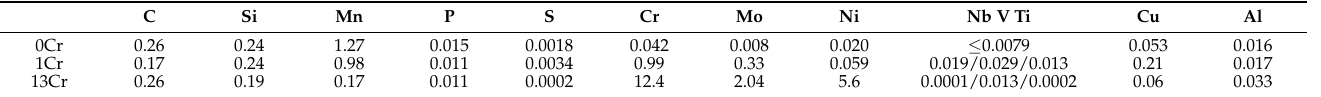
Table 1. Actual chemical compositions (wt.%) of three types of steels used in this